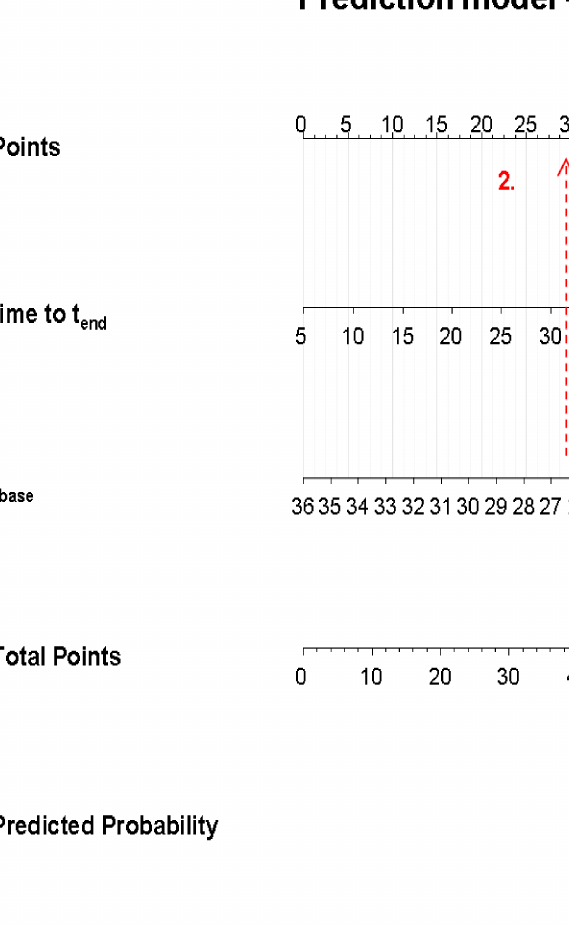
Figure 7. The nomogram constructed from the final logistic regression model generated from the described thermographic procedure. The red illustrations mark an example of how to read the nomogram (a set of values generated from a patient); time to t end = 60 min., t base = 26.5 ◦ C. In this example, the predicted probability of RP is above the cut-off value of 0.46 (blue line) and according to the thermographic test, the patient is positive for RP. For predicted probabilities below the cut-off value, diagnosis will be rejected. t base = baseline finger temperature, time to t end = time to end